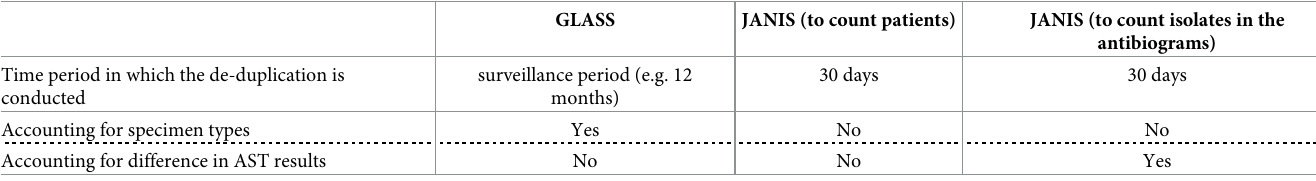
Table 1. Differences in the de-duplication methods from GLASS and JANIS.